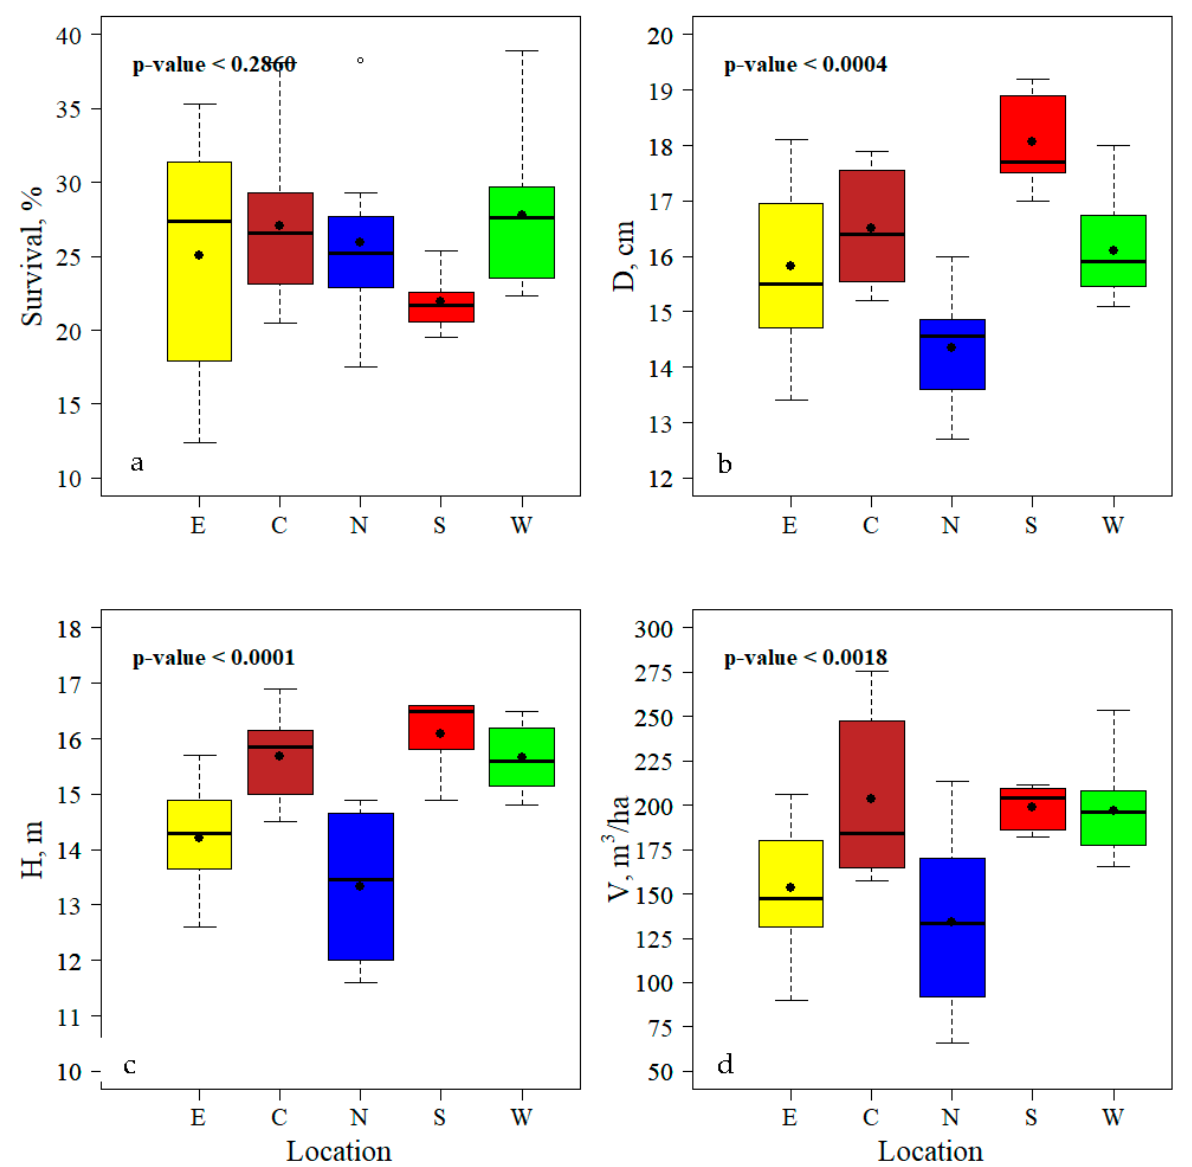
Figure 6. The mean growth and yield values ( a ) survival rate, ( b ) quadratic mean diameter, ( c ) mean height and ( d ) volume of growing trees per hectare of Scots pine ( Pinus sylvestris ) provenances, grouped by their eastern (E), central (C), northern (N), southern (S) and western (W) loca- tions.